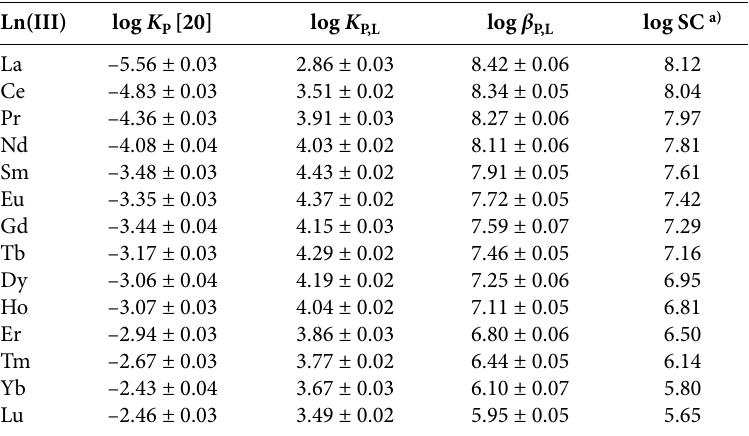
Table 1 . Values of the equilibrium constants K P , K P,L , log β HP,L as well as values of syner- gistic coefficients SC for Ln(III) extraction with HP-compound III mixtures in toluene. Ln(III) log K P [20] log K P,L log β P,L log SC